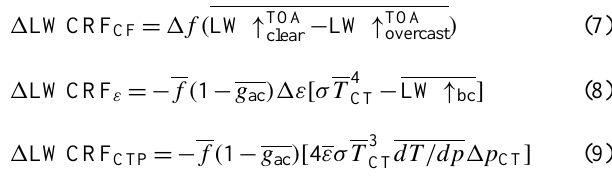
As before, the overbar indicates cluster averages and the 1 indicates the difference between warm and cold subsets.